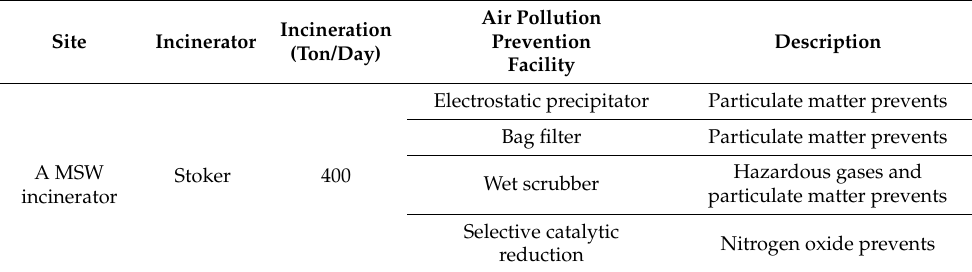
Table 1. Characteristics of the investigated MSW incinerator.